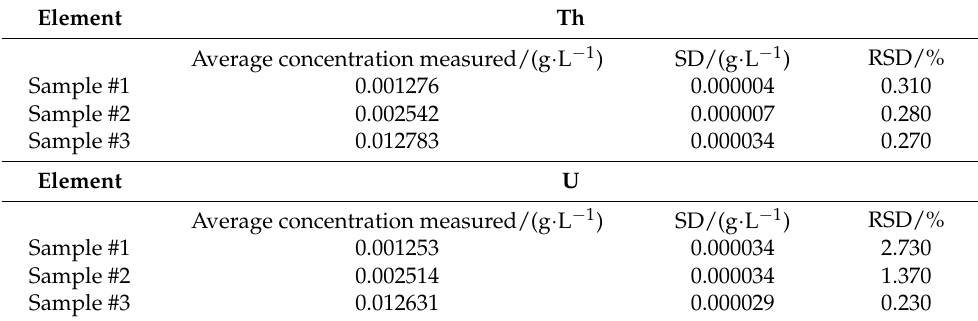
Table 3. Standard deviation (SD) and relative standard deviation (RSD) of analysis elements.